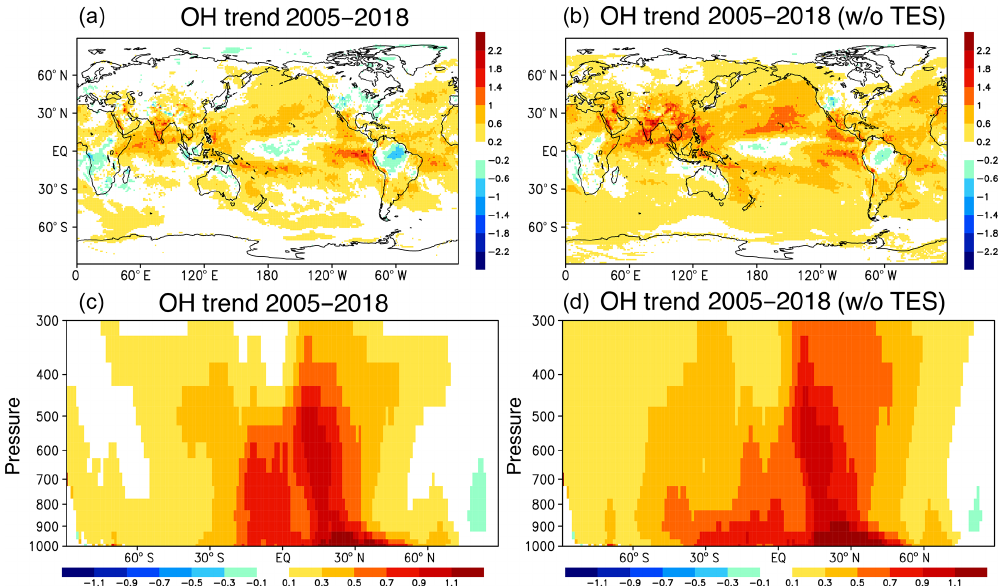
Figure 17. Same as Fig. 16 but for tropospheric OH (in 10 4 moleculescm − 3 per year, a , b ) and the latitude–pressure cross-section of OH trends (in % per year, c , d ) for the years